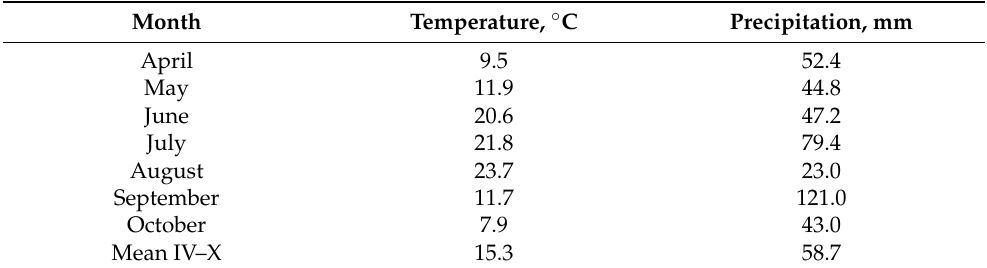
Table 8. Average monthly air temperatures ( ◦ C) and total monthly precipitation (mm) during the growing